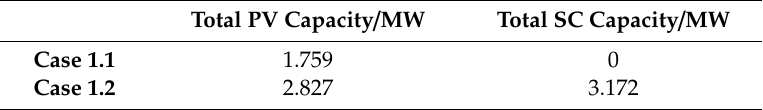
Table 1. Accommodation capacity comparison for Cases 1.1 and